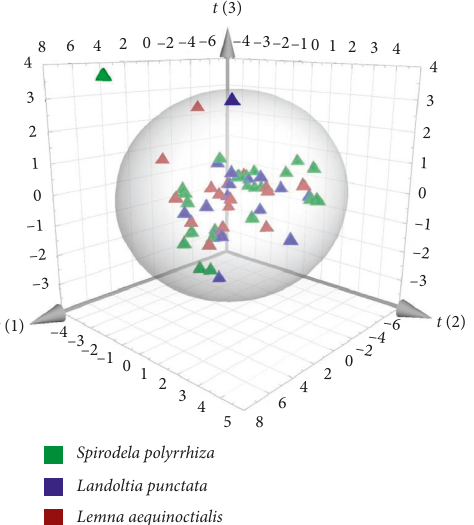
Figure 4: Three-dimensional score plot of principle component analysis (PCA) based on the ratio of free to total amino acids.